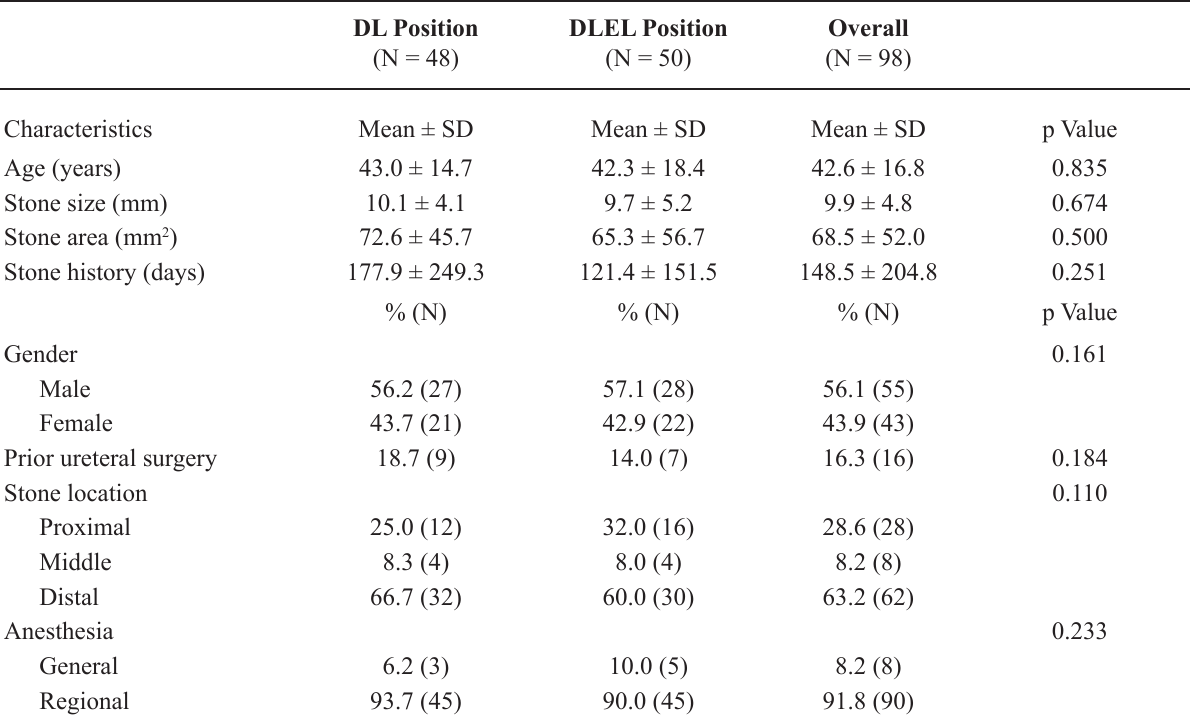
Table 1 – Characteristics and perioperative data in patients submitted to ureteroscopy in dorsal lithotomy (DL) position and in dorsal lithotomy with extended leg (DLEL)